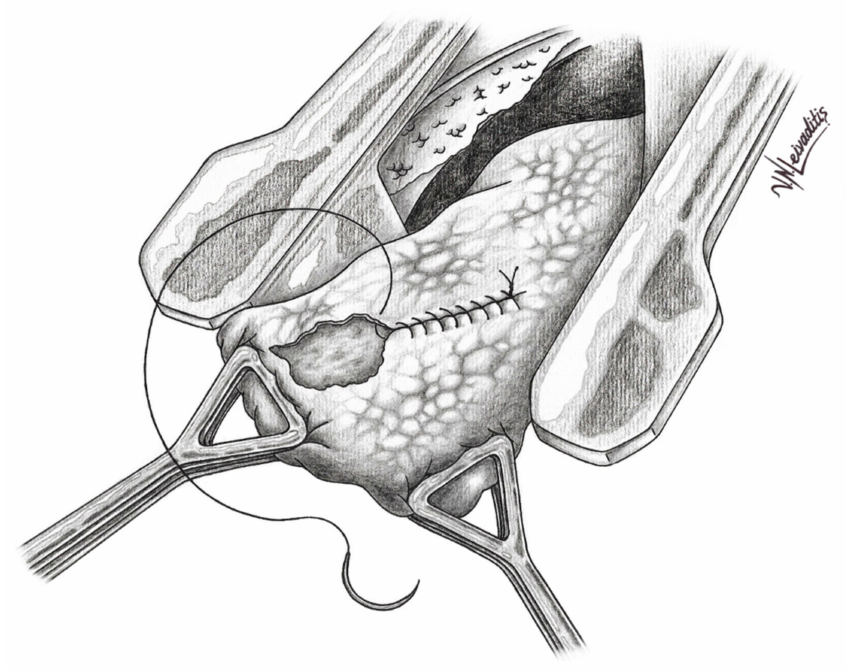
Figure 2. The lung parenchyma is reconstructed after the resection of the lung metastasis resection by re-approximating the visceral pleura with an absorbable